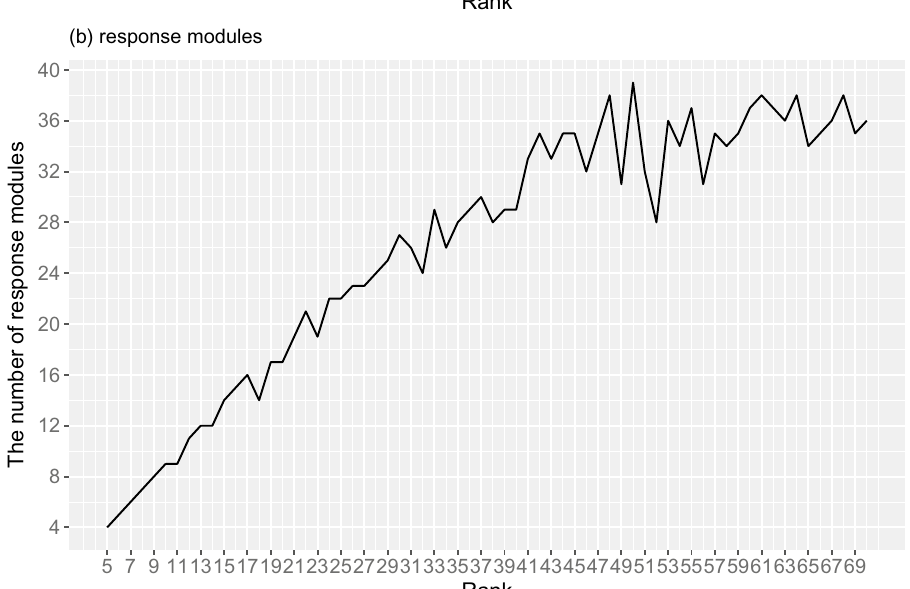
Figure 2. The number of predictor modules ( a ) and response modules ( b ) showing significant density score with respect to the parameter rank. The x-axis represents the candidate values for parameter K and y-axis represents the number of significant